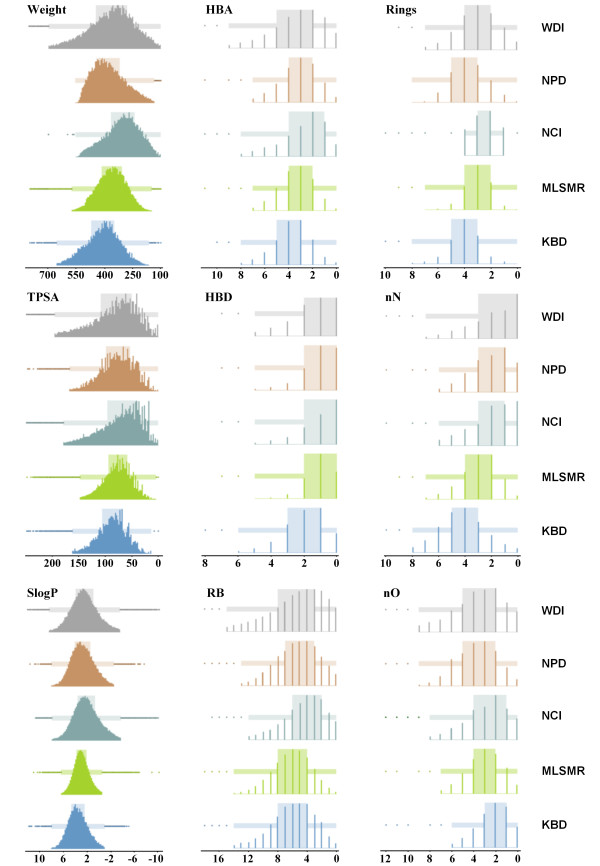
Distribution maps of nine calculated physicochemical descriptors for five databases: WDI (grey), NPD (orange), NCI (teal), MLSMR (green), and KBD (blue). Each box plot shows a wide rectangular block of interquartile range (IQR) between the 1st quartile and 3rd quartile (covering 50% of the total range). A long, narrow, solid rectangle is also shown within the IQR, indicating upper and lower adjacent values (UAV and LAV). The dots beyond UAV and LAV are outliers.